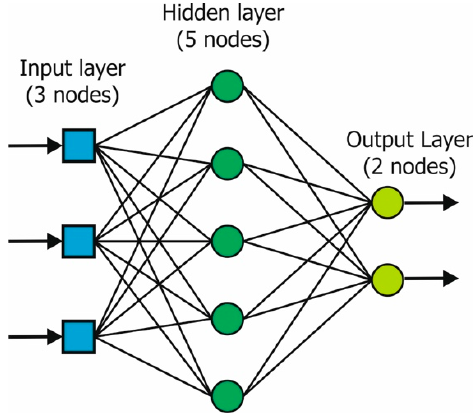
Figure 1. Example of an ANN (3-5-2).